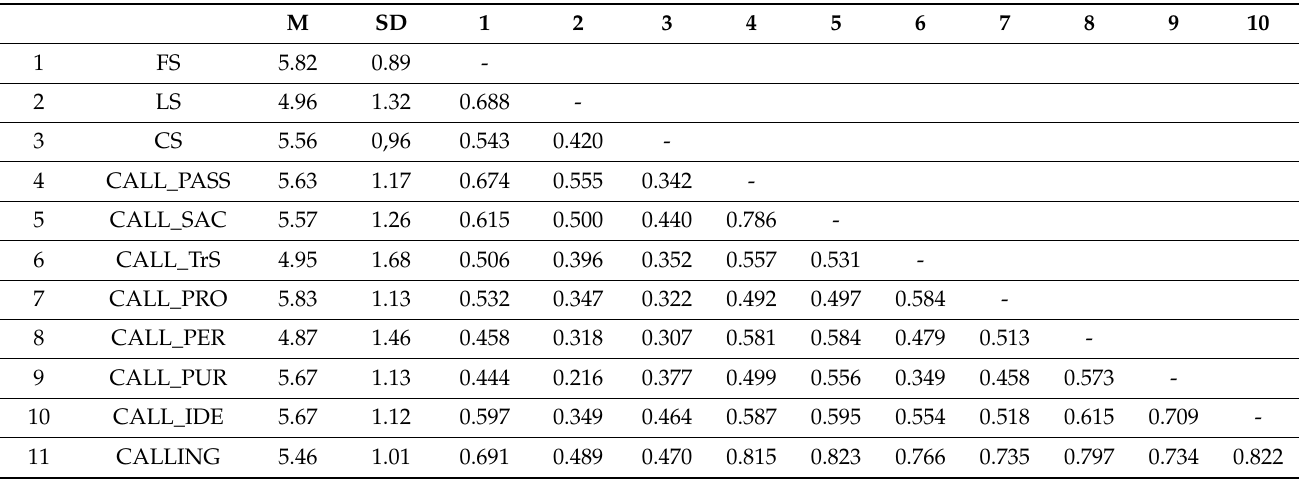
Table 1. Means, standard deviations and correlations among study